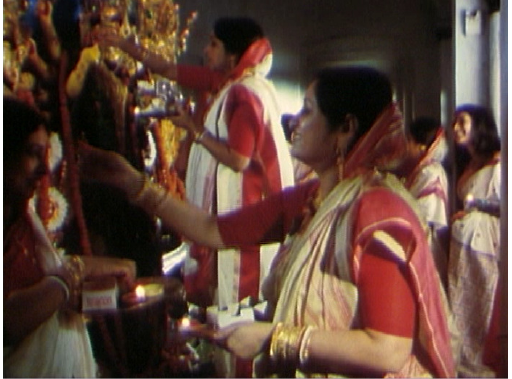
Figure 9. Sindoor khela (playing with vermilion), screen grab, Utsab